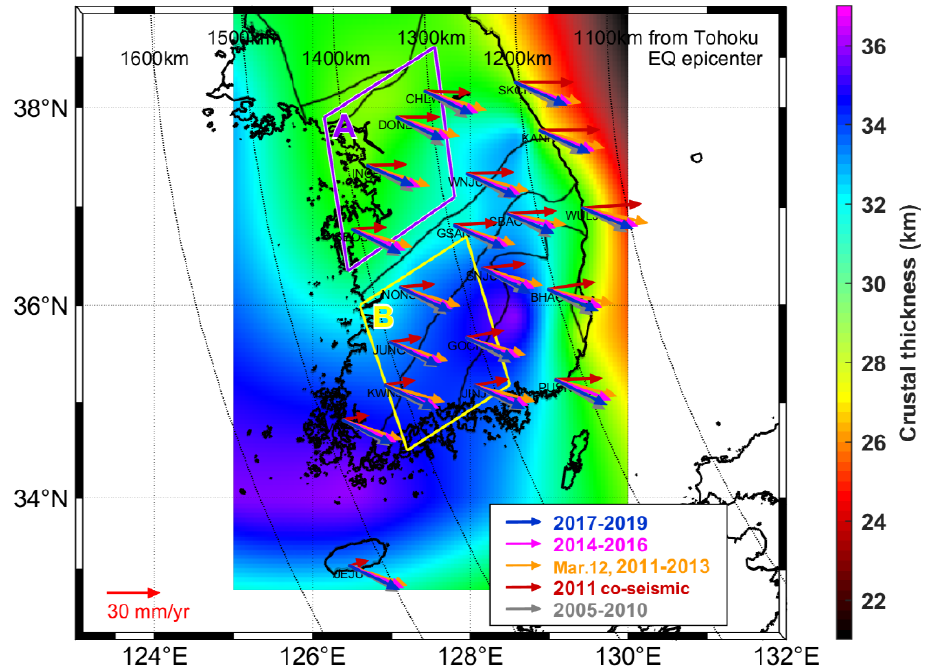
Figure 5. Velocity vectors of the stations and crustal thickness (from Hong et al. [29]) in South Korea in five periods. A crustal movement recovery is different according to the crustal thicknesses. The two areas ‘A’ and ‘B’ have similar epicenter distances but different crustal thicknesses. The crust thicknesses in areas ‘A’ and ‘B’, located between 1300 and 1400 km of epicentral distance, are 28–31 km and 33–36 km, respectively. The movements caused by the earthquake show a pattern of slowly returning to the pre-earthquake direction. Note: In the 2011 co-seismic stage (red arrows), the unit of magnitude is mm. It is a total displacement, not a rate.